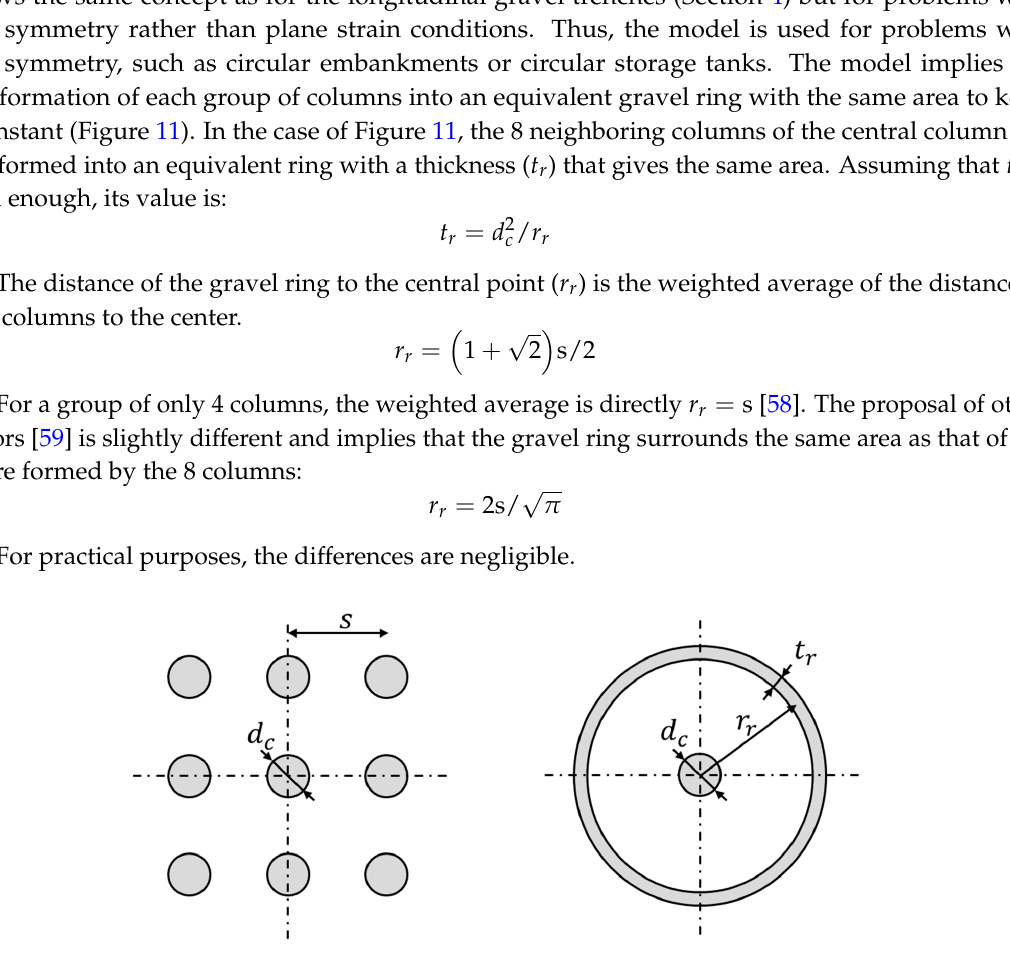
Figure 11. Transformation of stone columns in equivalent gravel rings.